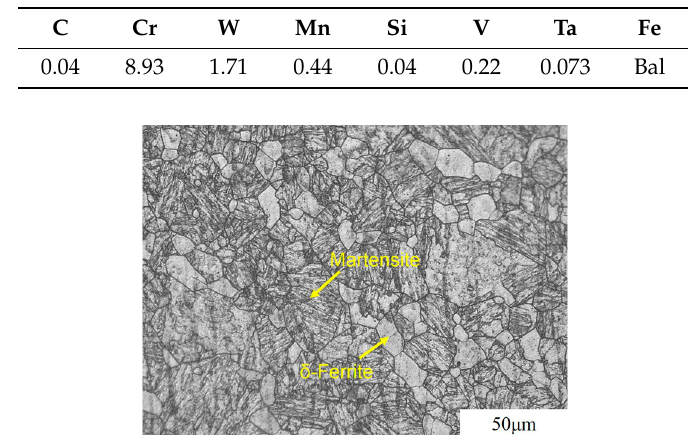
Table 1. Chemical compositions of experimental steel (wt %).